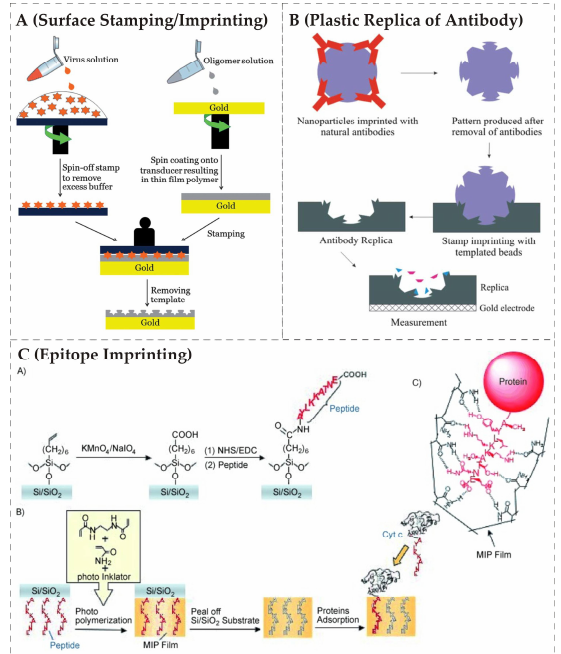
Figure 1. ( A ) surface stamping/imprinting method where the template i.e., viruses are assembled on stamp and then pressed over pre-polymer layer to generate patterned surface, reproduced with permission from [88]; ( B ) synthesis of plastic replica of antibodies is shown, in the first step antibody templates are imprinted in nanoparticles; afterwards, the templates are removed and resulting nanoparticles are collected on a stamp for pressing the pre-polymer layer, reproduced with permission from [83]; ( C ) epitope imprinting ; in the first step, the glass surface was modified; the second stage shows the attachment of the peptide and subsequent molecular imprinted polymer MIP formation; then, the glass substrate is removed, and, finally, the attachment to protein through its epitope is shown, reproduced with permission from